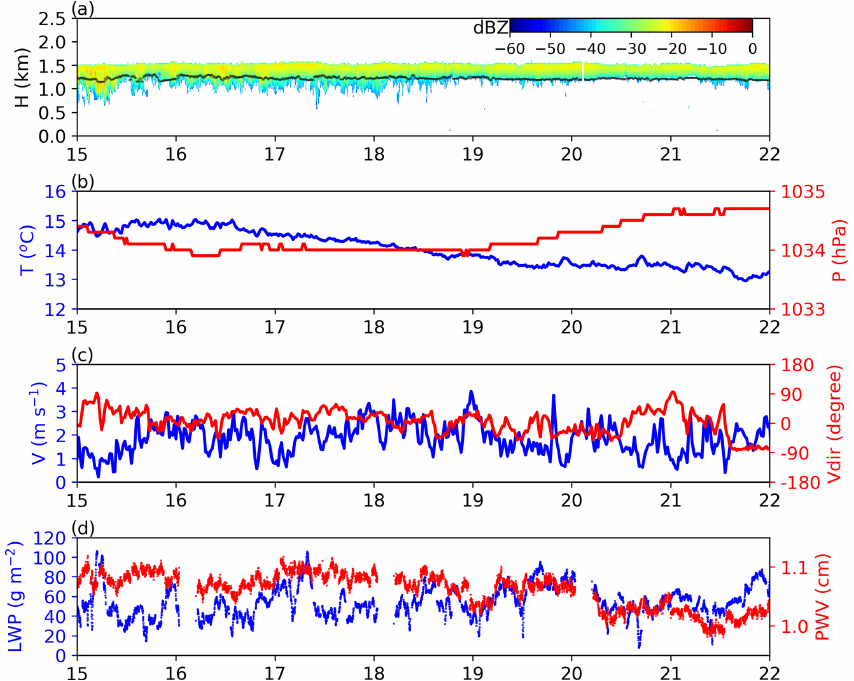
Figure 1. Cloud- and environmental-property time series observed at the eastern North Atlantic (ENA) site on Graciosa Island (39 ◦ 5 (cid:48) N, 28 ◦ 1 (cid:48) W) on 7 February 2018. Shown are (a) cloud-base height (black line) and Ka-band radar reflectively (colored shading), (b) surface temperature (blue line) and pressure (red line), (c) surface horizontal wind speed (blue line) and direction (red line), and (d) liquid water path (blue line) and precipitable water vapor (red